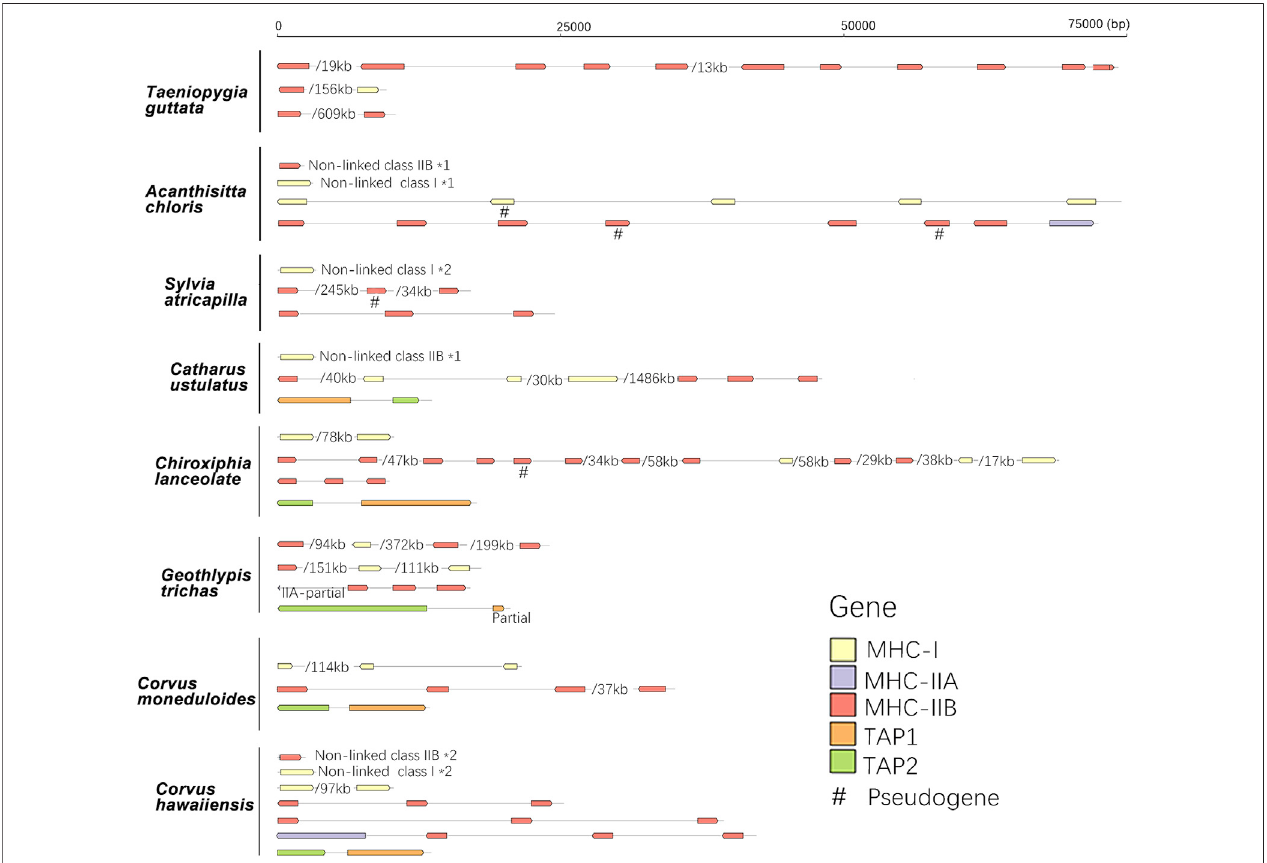
FIGURE 4 | The arrangement of MHC-I, MHC-II, and TAP genes in eight passerine bird species. A single slash indicates the same contig or chromosome and associated numbers indicate the length of missing distances, while *number indicates the number of duplication events. A single slash indicates the same contig or chromosome (numbers listed under the gene arrangement patterns indicate the total length of missing distances associated with single